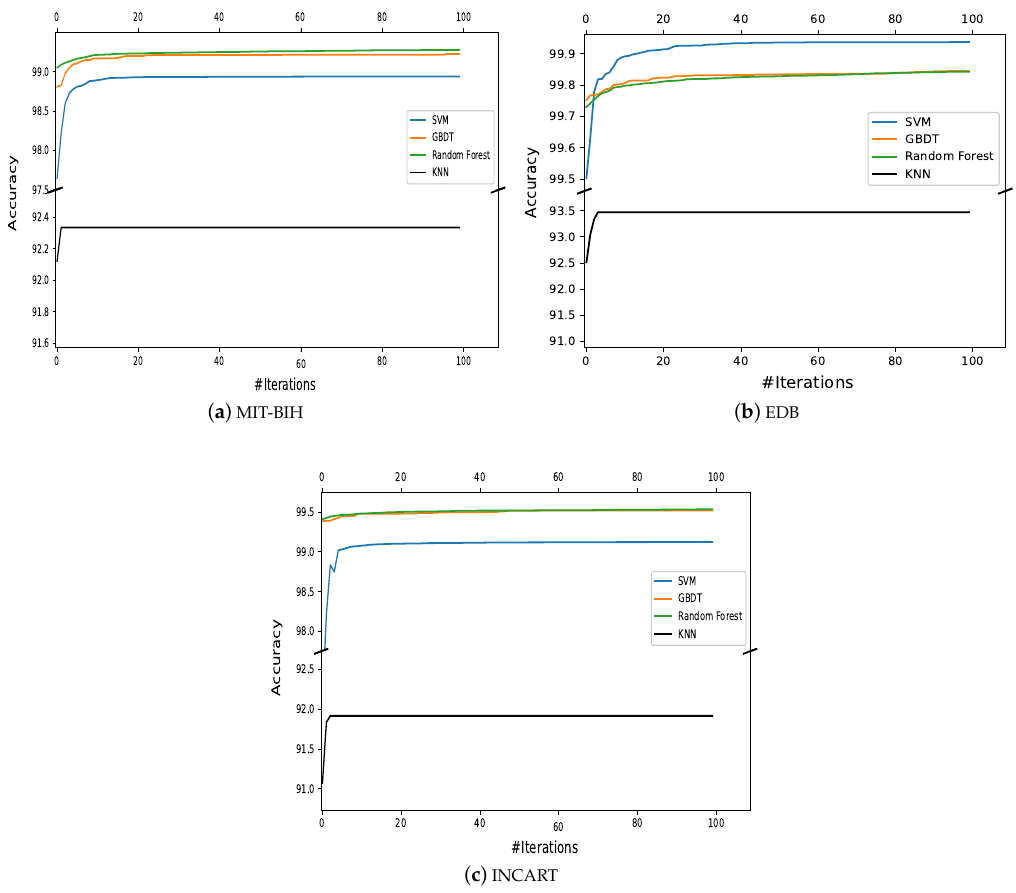
Figure 2. The convergence curves of the optimized classifiers on the three